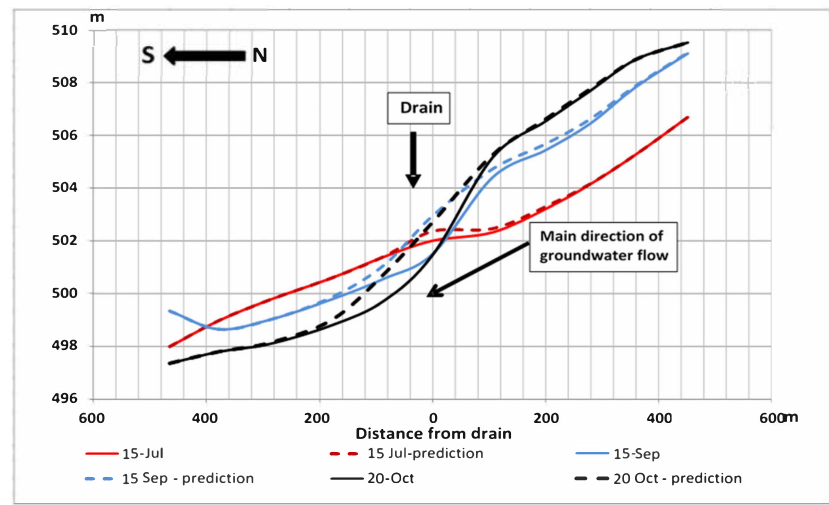
Figure 12. Groundwater level fluctuation spatial and temporal